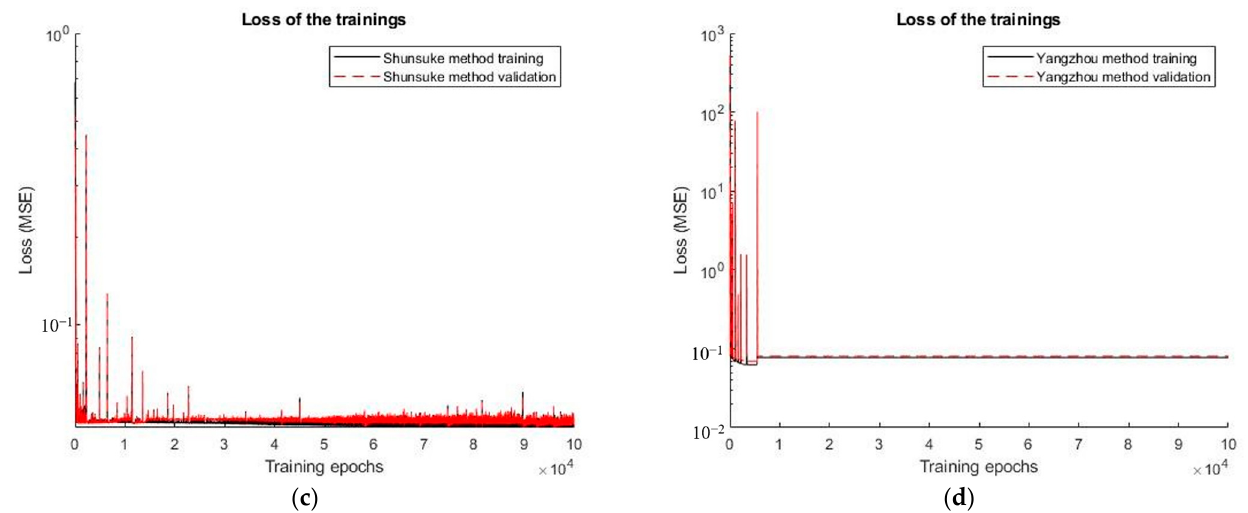
Figure 8. Results prior to min–max normalization. ( a ) Prediction errors obtained when using Yangzhou’s method and Shunsuke’s method. ( b ) Training epochs of Yangzhou’s method and Shunsuke’s method. ( c ) Verification training epoch of Shunsuke’s method. ( d ) Verification training epoch of Yangzhou’s method.